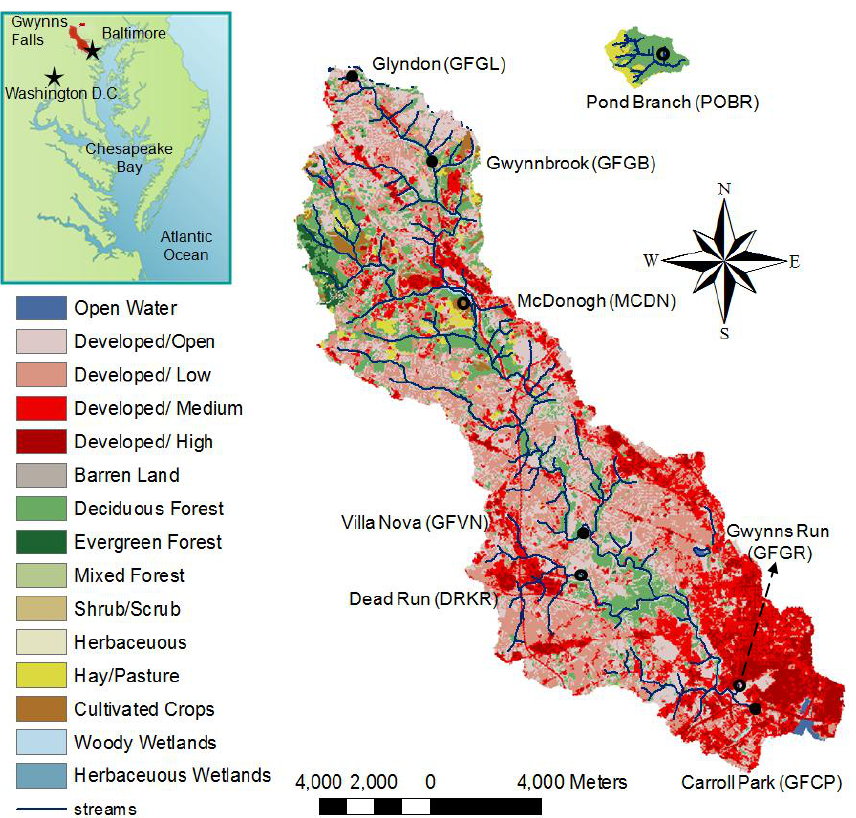
Fig. 1. Land use of the Gwynns Falls and Pond Branch watersheds, showing sites from which sediment and water were collected for incubations. Pond Branch is a watershed with forest as the dominant land use, and it is located in the nearby Gunpowder River. Solid and open circles represent sites of the main stem and tributaries, respectively. Resolution of the land use data is 30m, and land use and stream channel location data are from US Department of Agriculture (dtagateway.nrcs.usda.gove) and US Geological Survey (http://datagateway.